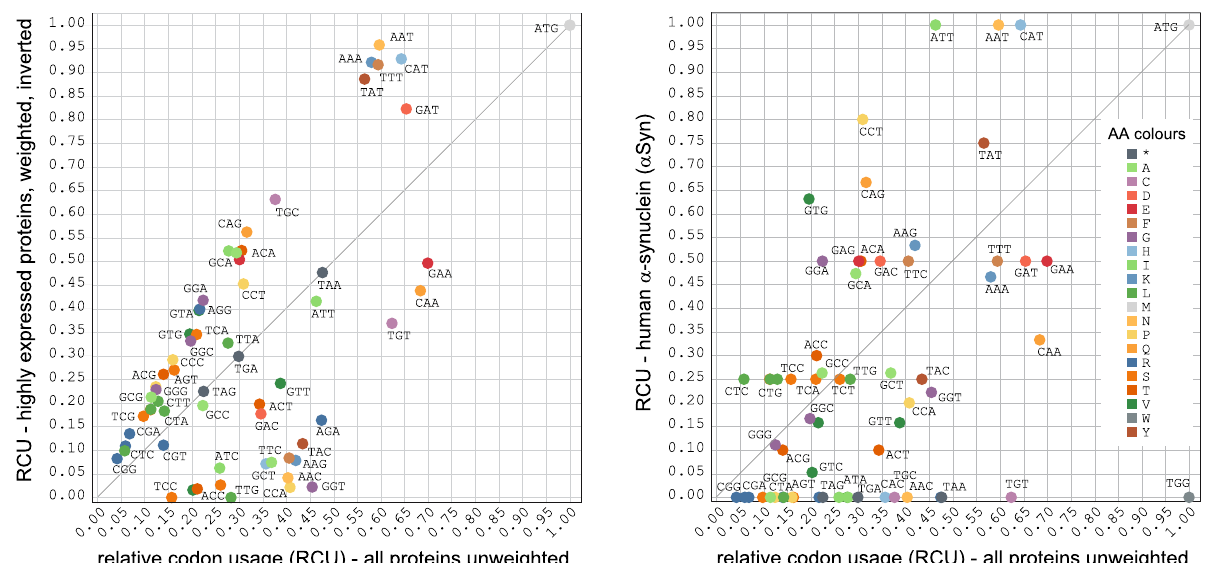
Figure 6. The “inverted” codon usage. The schematic view at the top demonstrates the generation of an inverted codon usage compared to that of a switched codon usage. The plots at the bottom show the relative codon usage of the 308 highest expressed proteins, when weighted and inverted (left plot), and the relative codon usage of human αSyn (right